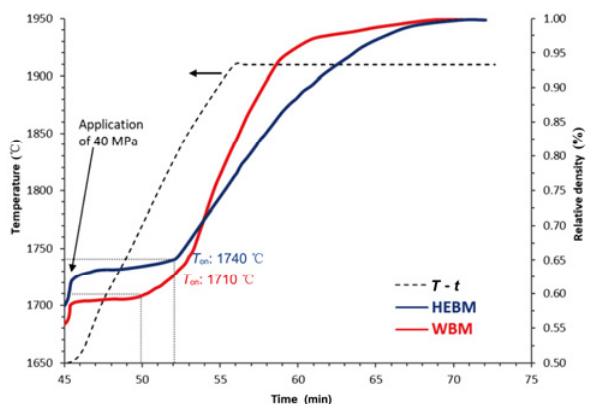
Fig. 3 Densification curves for the mixtures prepared by planetary high energy ball milling (HEBM) and conventional wet ball milling (WBM). Application of mechanical load and shrinkage onset temperatures ( T on ) are indicated.